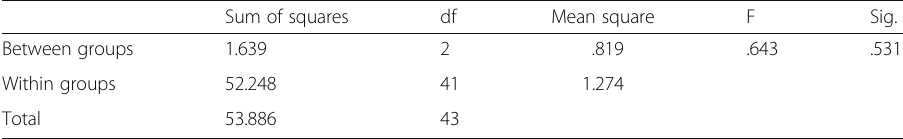
Table 4 One- way ANOVA on the groups ’ performance on the MKT as pre-test Sum of squares df Mean square Sig.